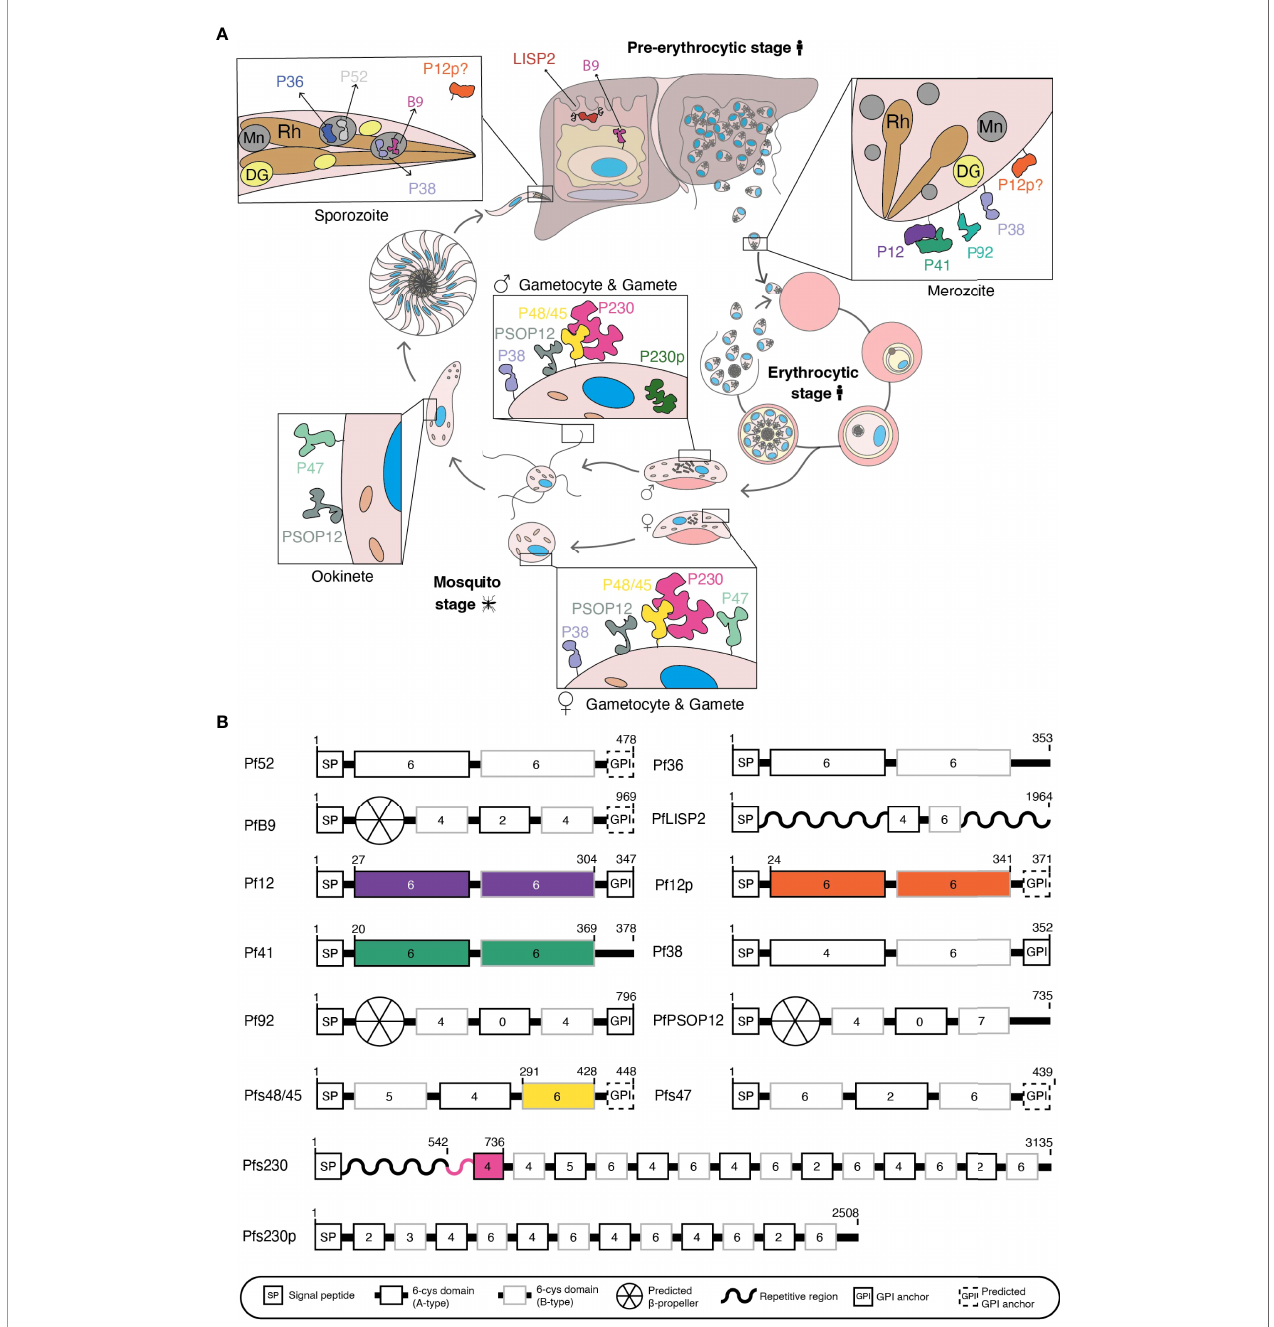
FIGURE 1 | (A) Schematic of Plasmodium falciparum life cycle. 6-cysteine proteins are expressed in the pre-erythrocytic and erythrocytic stages (merozoite) of the human host and the mosquito stages (gametocyte, gametes, zygote, ookinete, and sporozoite). Mn, microneme; Rh, rhoptry; DG, dense granule. (B) Domain architecture of the 14 P . falciparum 6-cysteine proteins. The illustration shows the signal peptide (SP), the number of cysteines within each domain (number in the boxes), A-type (black box), B-type (grey box) 6-cysteine domains, validated or putative GPI-anchors, and other speci fi c features (i.e. repetitive/non-structured region or putative b -propeller domain). Colored regions represent the part(s) of the protein for which crystal structures are